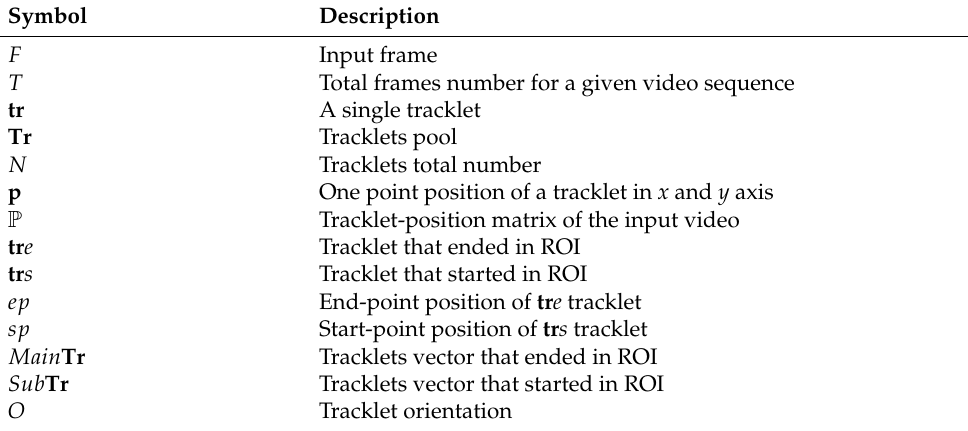
Figure 3. Steps of the process of the HTA algorithm. ( a ) Methodology flowchart. ( b ) An illustrative example of the HTA process. The tracklets that are illustrated by yellow color, 𝐭𝐫𝑒 (cid:3039) and 𝐭𝐫𝑠 (cid:2928) , are associated as one path at a final stage.